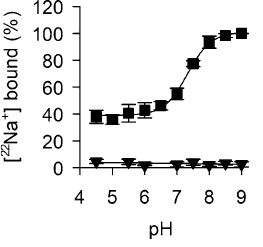
Figure 4. pH dependence of Na + binding to NhaA. Binding of 50 µM [ 22 Na]Cl (50 Ci mol −1 ) to 200 ng NhaA-WT (filled square) or NhaA-D163N (filled inverted triangle) was measured in assay buffer (containing 0.015% (w/v) DDM plus 5% (w/v) cardiolipin) with the indicated pH. Data of three independent experiments are shown as mean ± s.e.m. and plotted as a function of